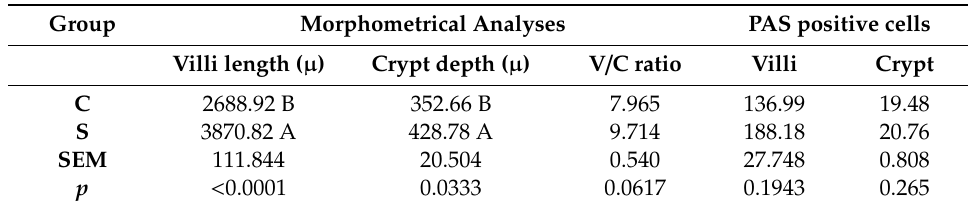
Table 3. E ff ect of Saccharomyces cerevisiae boulardii CNCM I-1079 supplemented diet on intestinal histology and